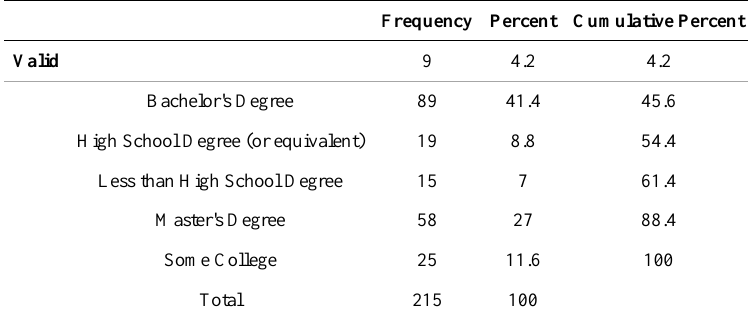
Table 4. Education (Questionnaire respondents)